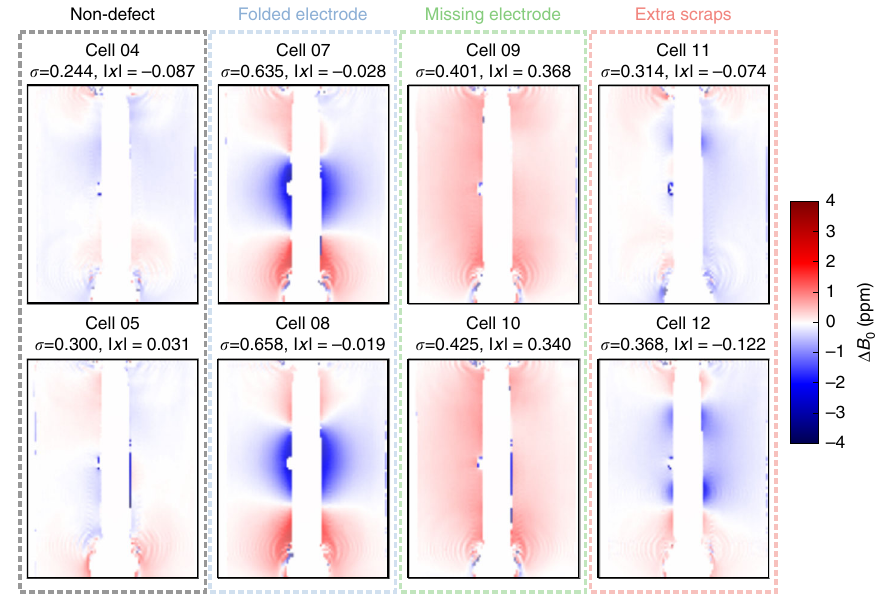
Fig. 4 Magnetic fi eld maps for the defective cells, with the mean and standard deviation indicated (taken over all the voxels in each image). The fi elds are given relative to one of the non-defect